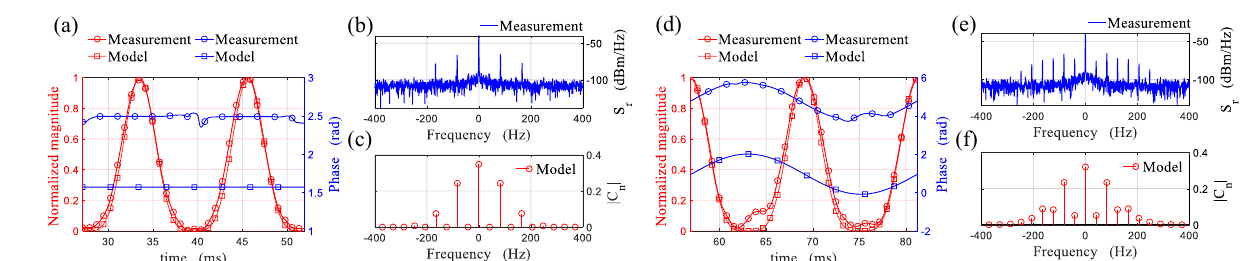
Figure 9. The magnitude and phase of the measured amplitude modulating waveform for ( a ) symmetrical, ( d ) non-symmetrical rotation of the loop compared with those predicted by the model. The measured PSD of the received signal backscattered from ( b ) symmetrically, ( e ) non-symmetrically rotating loop. The calculated Fourier coefficients of the time-varying complex envelope of the backscattered field from ( c ) symmetrically, ( f ) non-symmetrically rotating